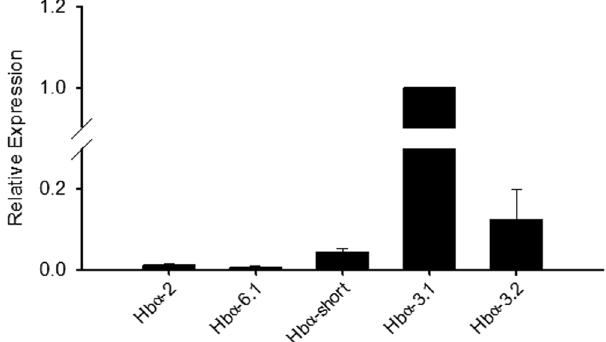
Figure 2. Relative mRNA expression of the five detectable Hb α subunits in red blood cells of S . ocellatus , as determined by real-time RT-PCR. Ef1 α served as an internal control, and all expression value were calculated relative to the Hb α -3.1 subunit. All values are mean ± S.E.M; N = 7.